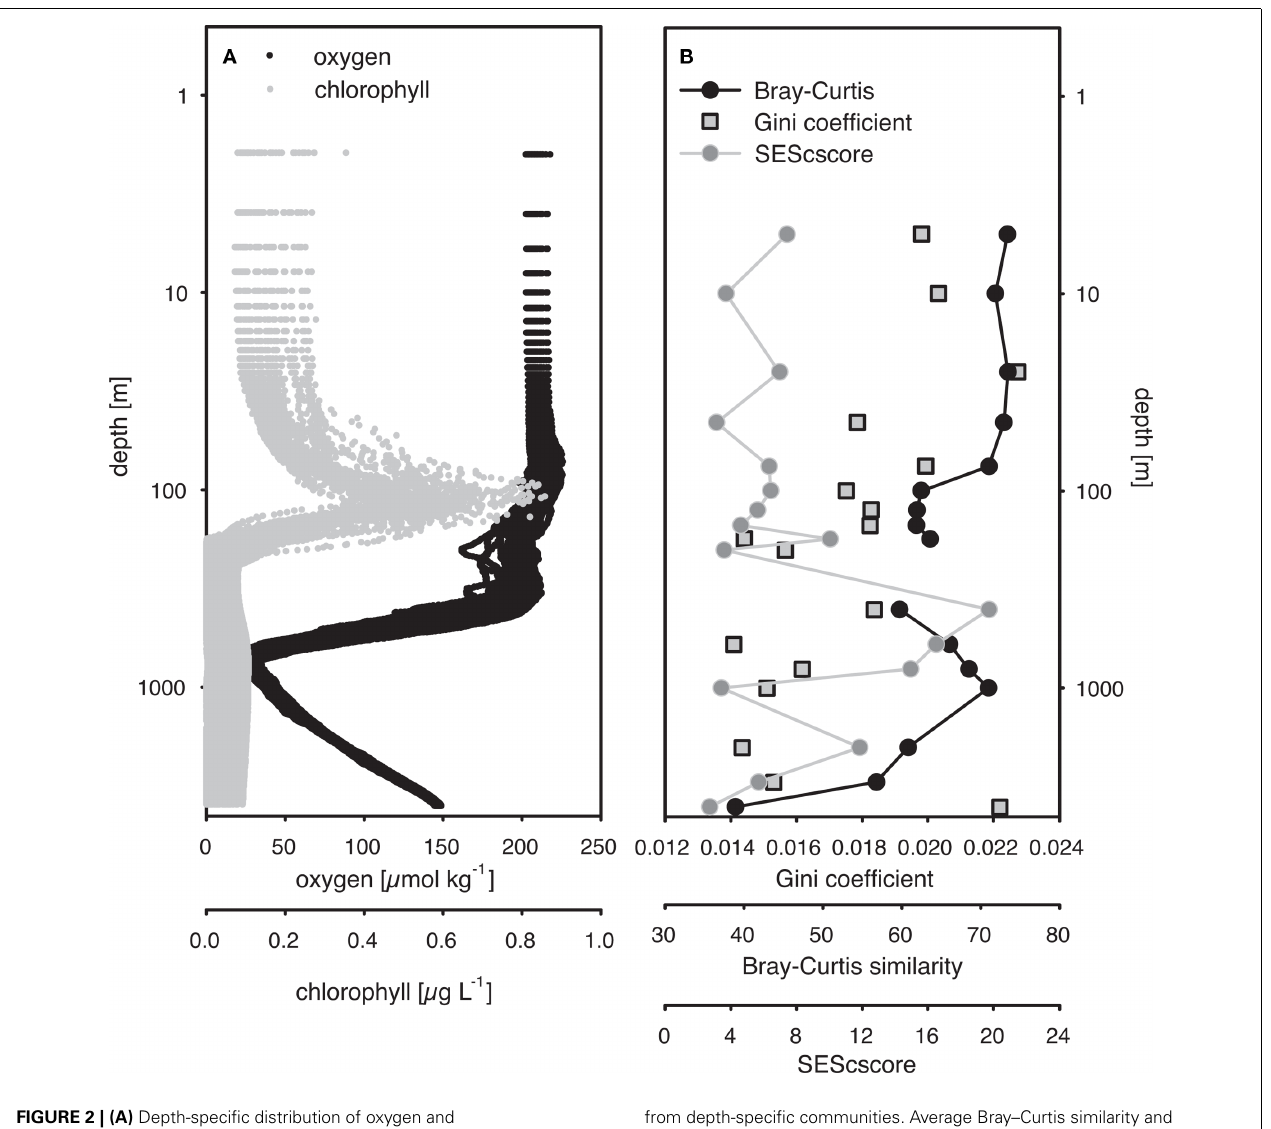
FIGURE 2 | (A) Depth-specific distribution of oxygen and chlorophyll a concentrations from HOT cruises 165–200 (November 2004 to February 2008). (B) Standardized effective size of C -score (SEScscore), average Bray–Curtis similarity from all pariwise comparisons within a single depth, and Gini coefficients